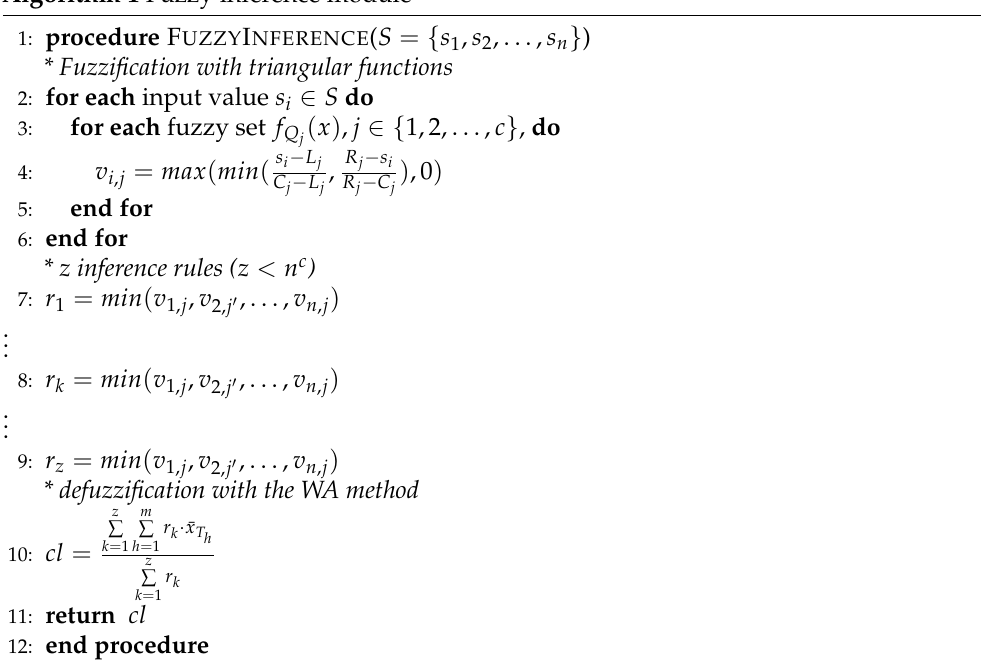
Algorithm 1 Fuzzy inference